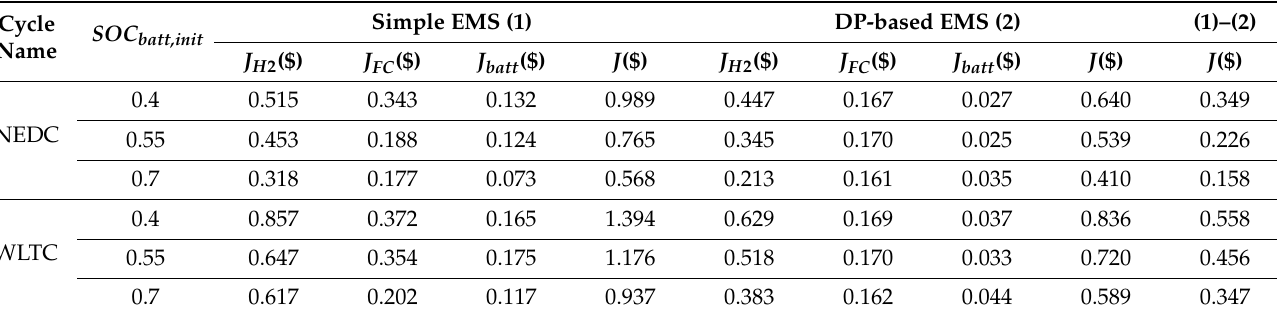
Figure 5. Dynamic programming results when the initial battery SOCs are 0.4, 0.55, and 0.7, respec- tively: ( a ) NEDC driving cycle; ( b ) WLTC driving cycle.